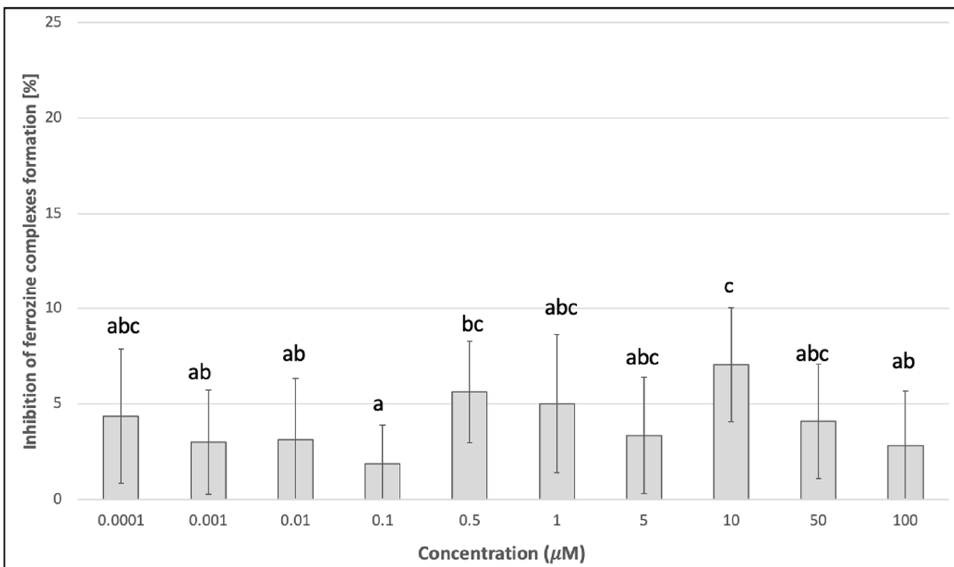
Figure 5. Chelating activity of skyrin. Each value is expressed as mean ± standard deviation. Results were analyzed by ANOVA single-step multiple comparisons of means using LSD tests, and comparisons between the mean values were considered significant at p < 0.05. Similar letters represent samples with no statistically significant differences between them. All experimental data in this work are from at least three independent experiments.